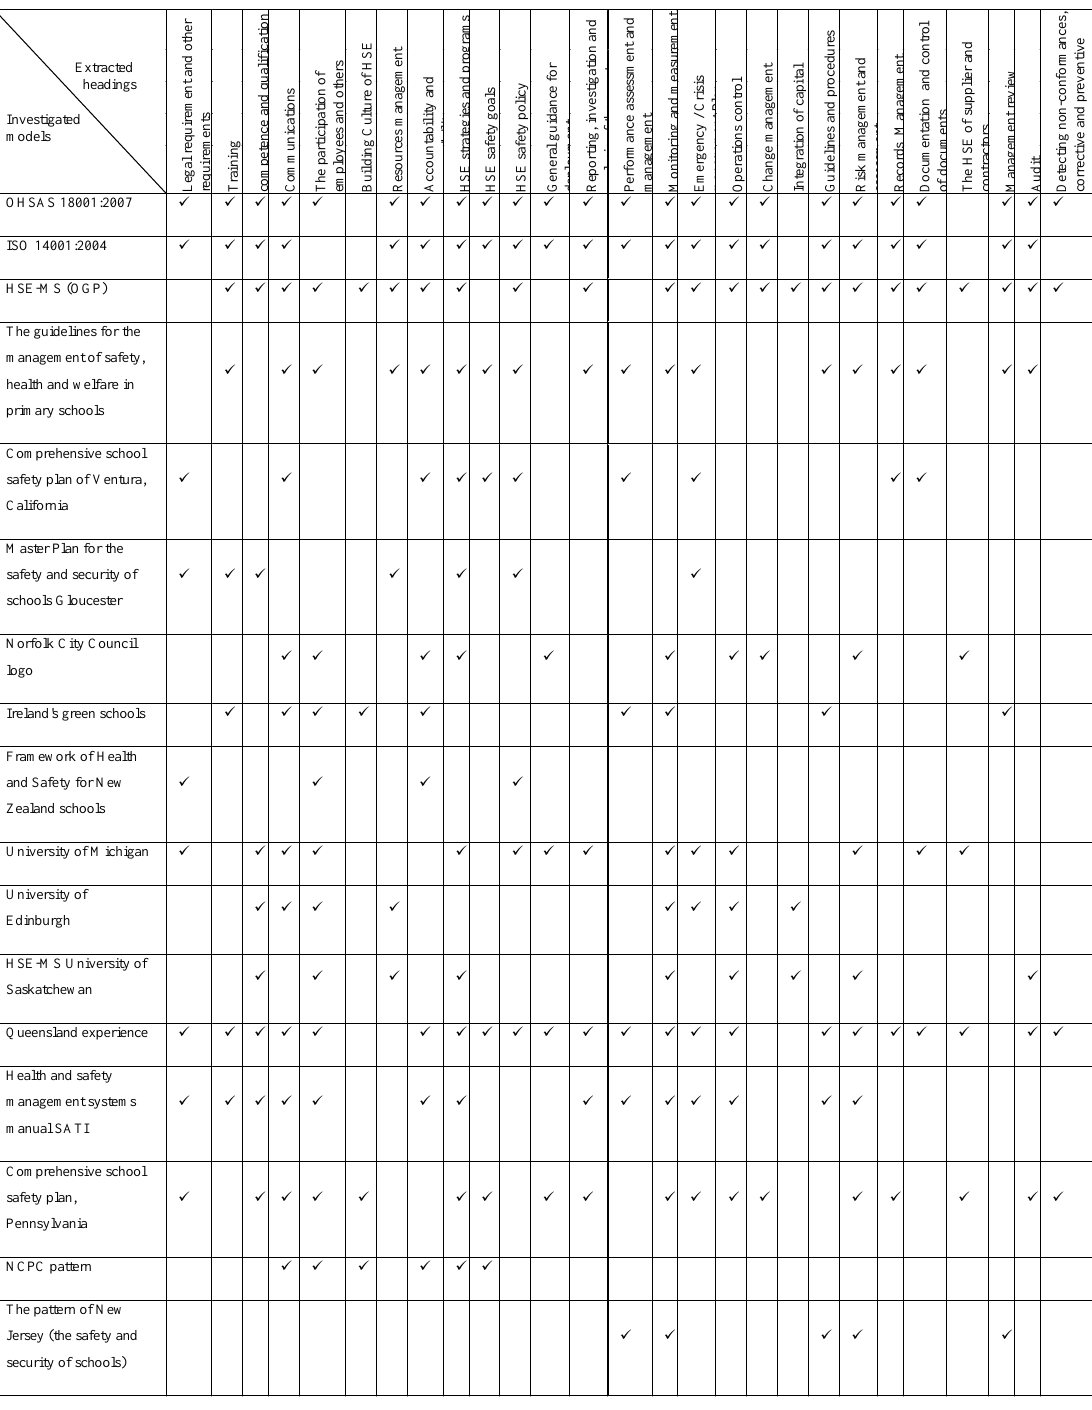
Extracted headings